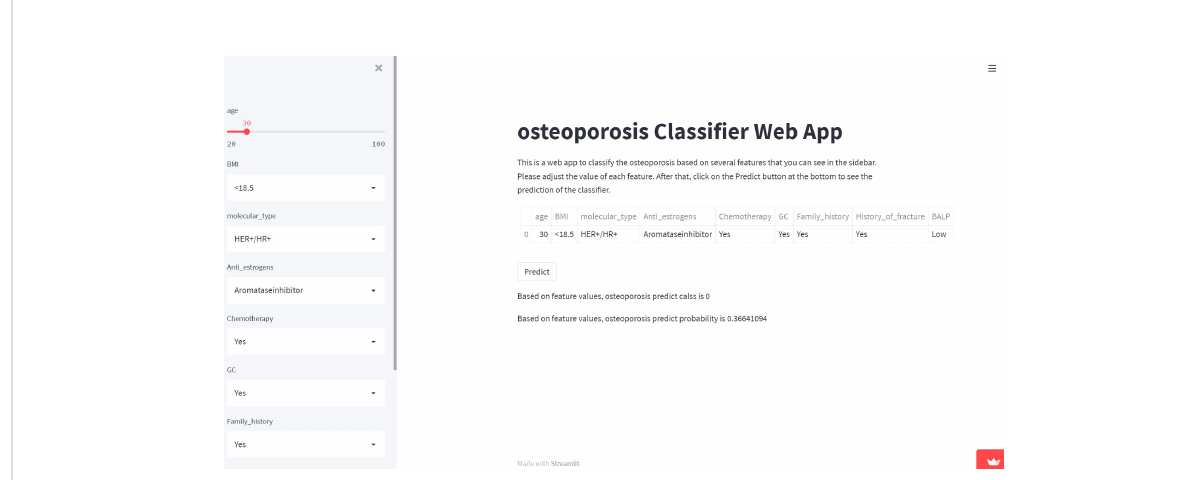
FIGURE 5 Screenshot of the web-based model. Screenshot of the XGB osteoporosis predicting model, which is available at https://share.streamlit.io/